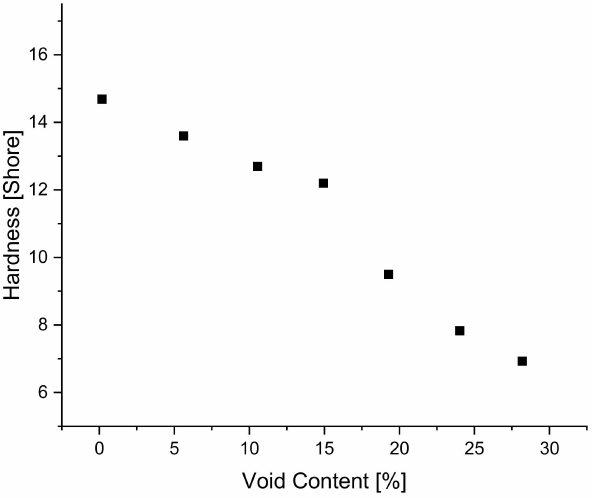
Figure 15. The influence of void content on